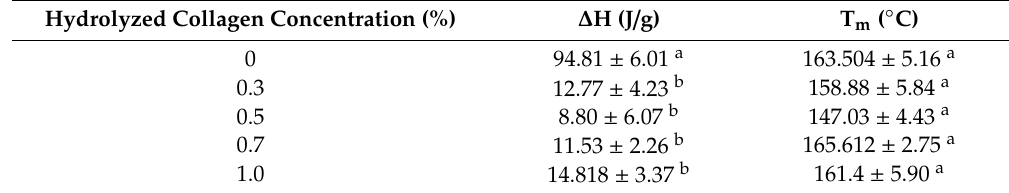
Table 2. Enthalpy ( ∆ H) and melting temperature (T m ) of fermented whey beverages following thermal treatment at 60 ◦ C for 30